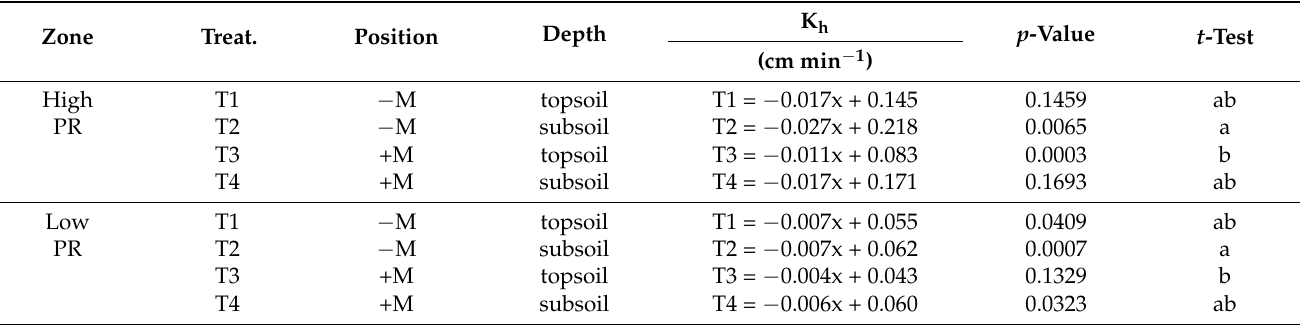
Table 2. Linear model and its coefficients for unsaturated hydraulic conductivity (K h ) as a function of the supply pressure (Pa) for the averages of the replicates. Different letters indicate statistically significant differences ( p <0.05) according to the t -test.